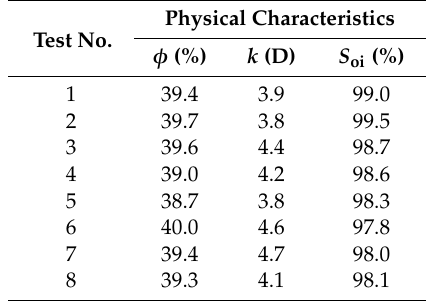
Table 1. The physical characteristics of the 2-D sandpacked physical model in Tests #1–8 at T res = 21.0 ◦ C. Physical Test No.